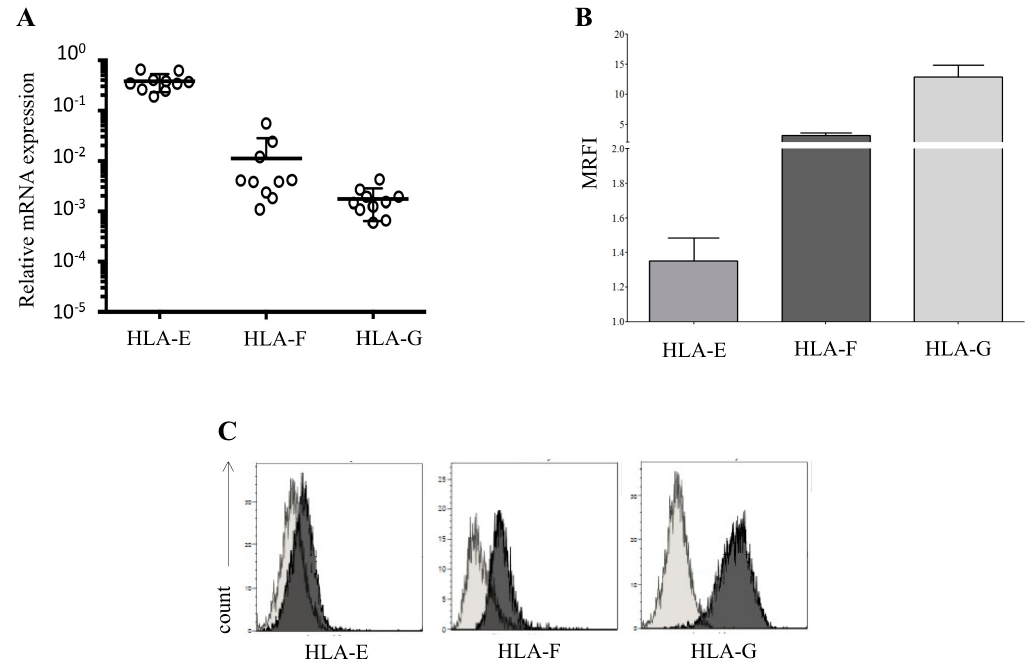
Figure 1. Expression of HLA-class Ib molecules by human amnion epithelial cells (hAECs). ( A ) Transcriptional analysis on 10 different batches of hAEC for all three HLA-Ib molecules; ( B ) the expression of immunomodulatory molecules HLA-E, HLA-F and HLA-G was assessed by flow cytometry on 17 different batches of hAEC. Data are expressed as mean relative of fluorescence intensity (MRFI) ± SE; ( C ) Panel C shows a representative staining. Light grey profiles indicate staining with isotype control, whereas dark grey profiles indicate staining with specific mAbs.